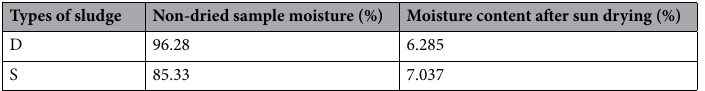
Table 3. Non-dried and sun dried sample moisture content.